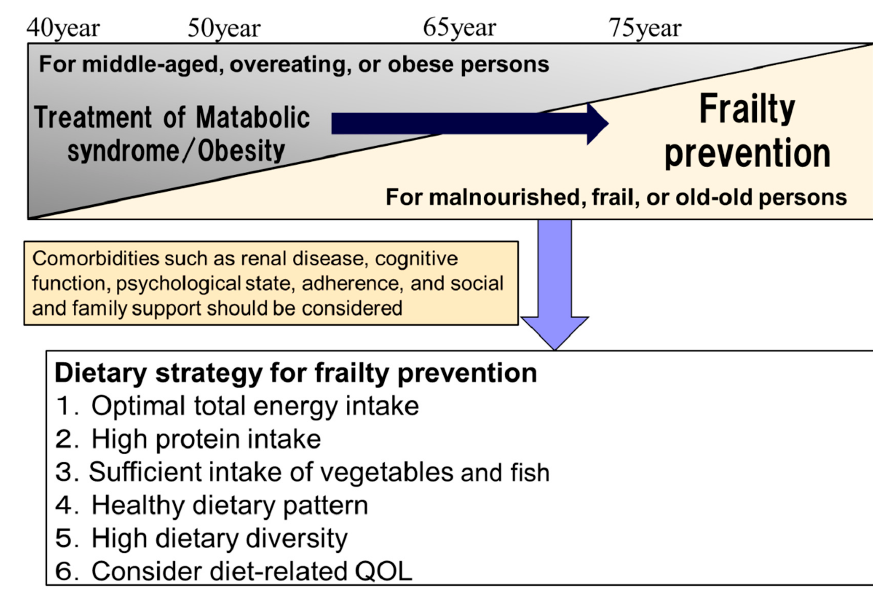
Figure 4. Shift in dietary strategies for frailty prevention in older adults with diabetes. For